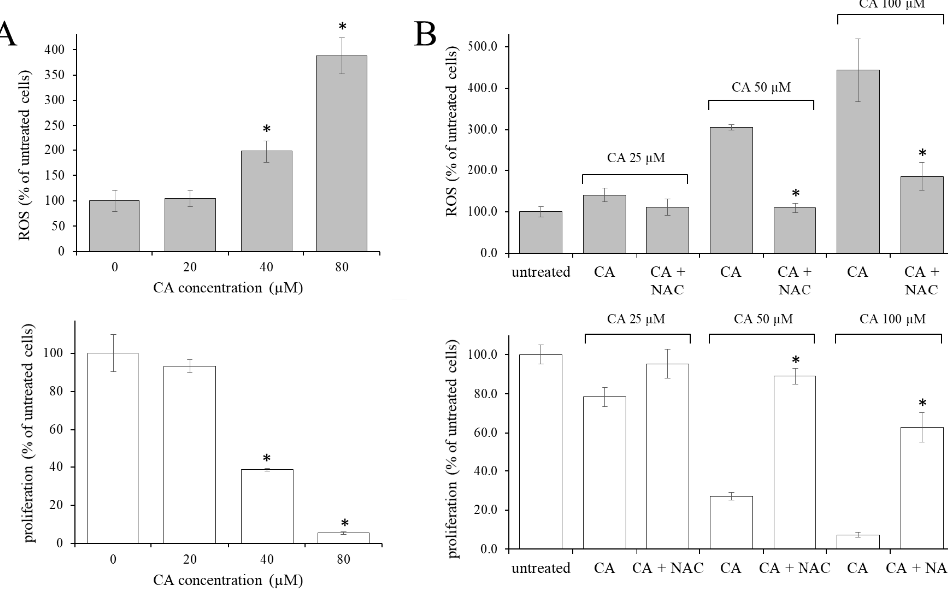
Figure 1. Effect of CA treatment on cell proliferation and on ROS level in K562 cells. ( A ) Dose-dependent effect of CA on ROS level ( upper side ) and cells proliferation ( lower side ). Asterisks indicate significant differences ( p < 0.05) observed in CA treated cells versus untreated control (0). ( B ) Effects of NAC (38 µ M) and CA co-administration on ROS level ( upper side ) and cells proliferation ( lower side ). NAC = N -acetyl cysteine, CA = caffeic acid. Asterisks indicate significant differences ( p < 0.05) obtained upon simultaneous administration of CA and NAC compared to CA-treated cells.